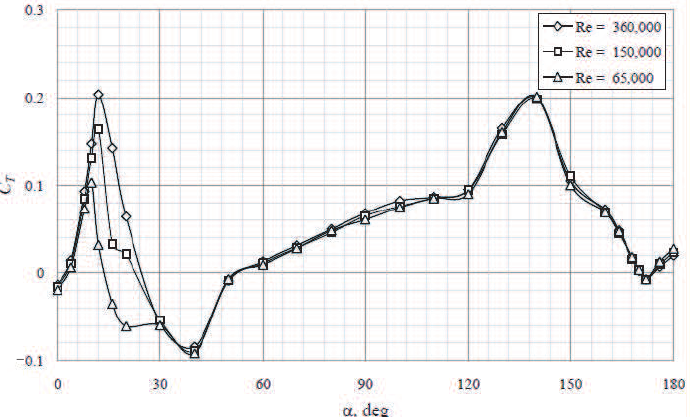
Figure 24. Tangential force as a function of AOA at varying Reynolds